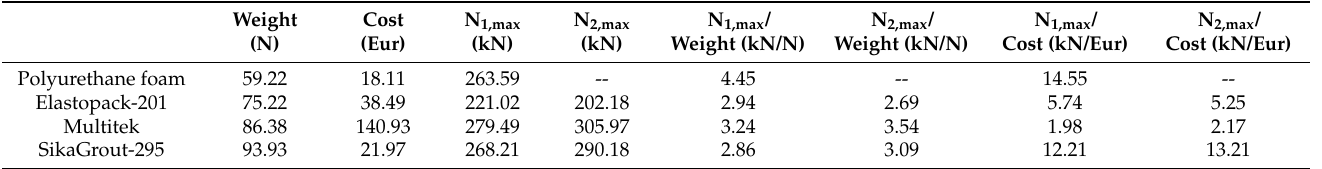
Table 4. The weight and cost values of the hybrid elements and the ratio of the values obtained in the tests in each of the cycles (N 1,max y N 2,max ) with respect to